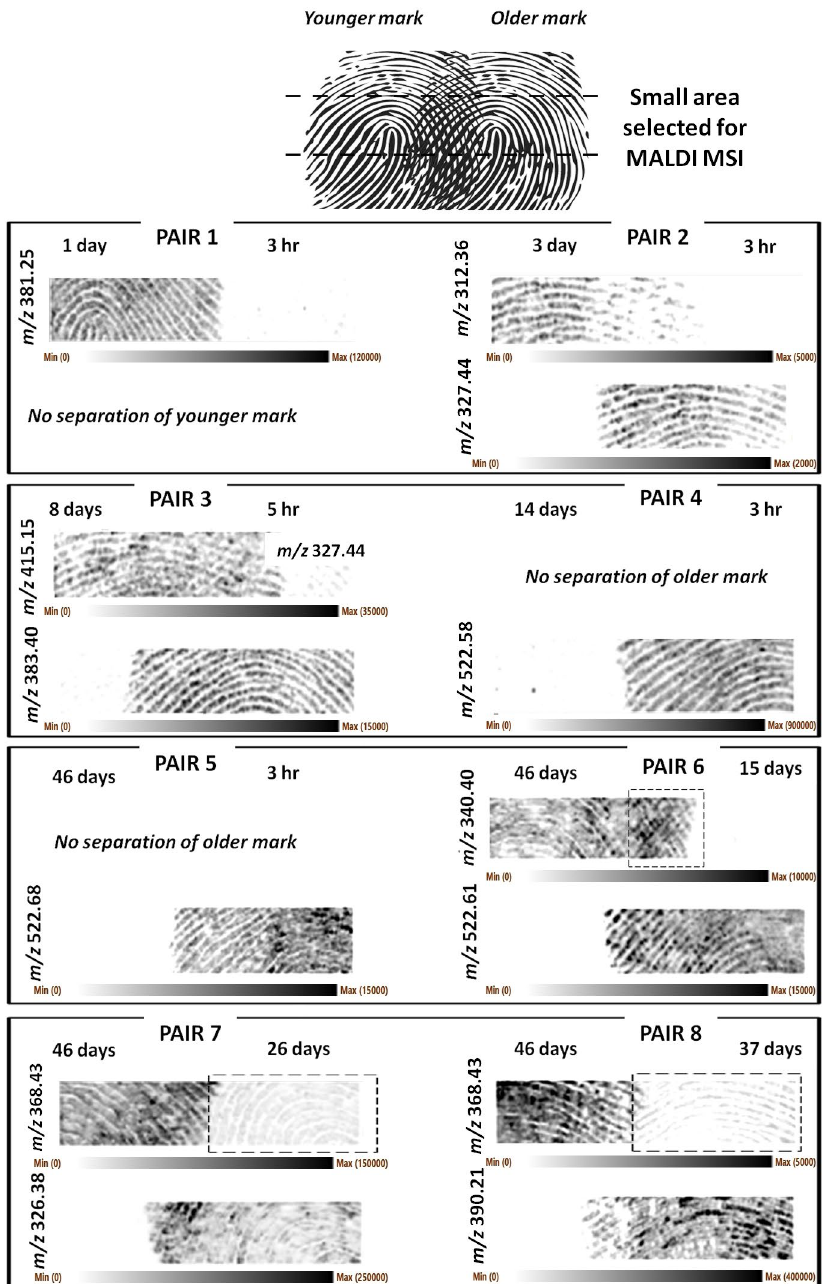
Figure 2. MALDI MS images of eight pairs of partially overlapping natural fingermarks deposited on aluminium slides. Top part of the figure illustrates the schematics of the pair arrangements. The fingermarks were deposited by the same person and aged for the times indicated in the figure and in Table 2. Older marks could be separated for pairs 2–3, 6–8. Younger marks could be separated for all the pairs shown except for pair 1. The squared frame in pair 6 indicates part of the younger mark has not been resolved. The squared frames from pairs 7 and 8 indicate the m / z ion used to obtain the images of the older marks is also less abundantly present in the younger marks. MALDI MSI images have been obtained at 100 µm × 100 µm spatial resolution.